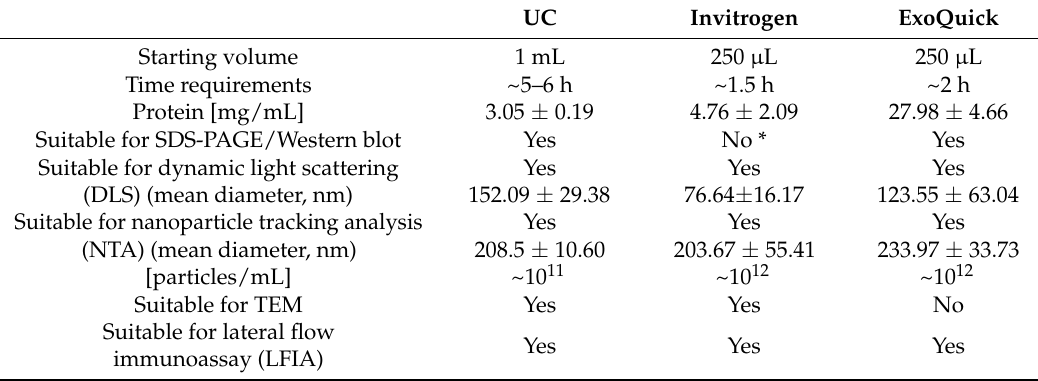
Table 1. Summary of the main aspects evaluated in our comparison study. * Not directly from isolated EV fractions, as previous protein precipitation or isolation without Proteinase K treatment is